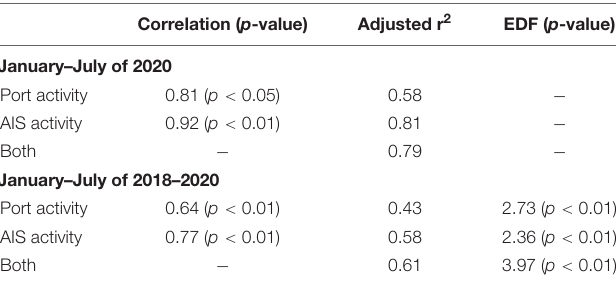
TABLE 2 | Summary of statistical relationships between monthly mean spectrum levels in the 63 Hz one-third octave band and shipping activity metrics ( Figure 9